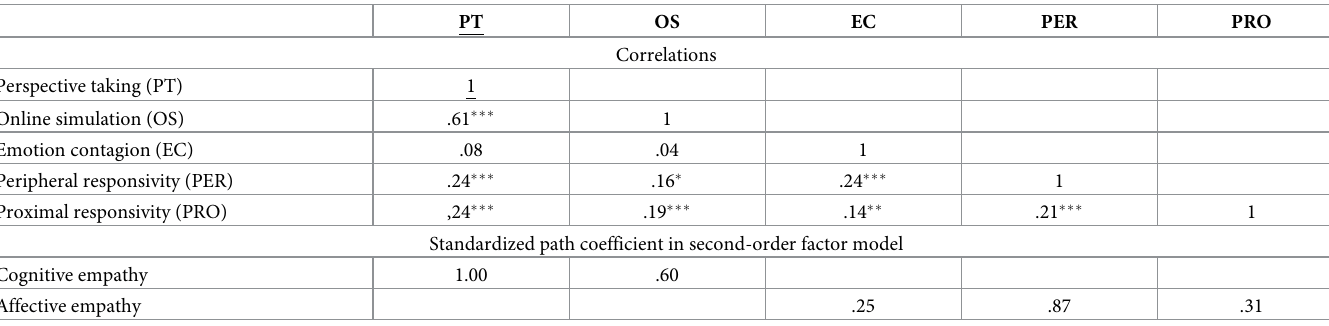
Table 3. Correlations for the factors in the QCAE ESEM-5 and standardized path coefficient in second-order factor model H-ESEM-5 models. PT